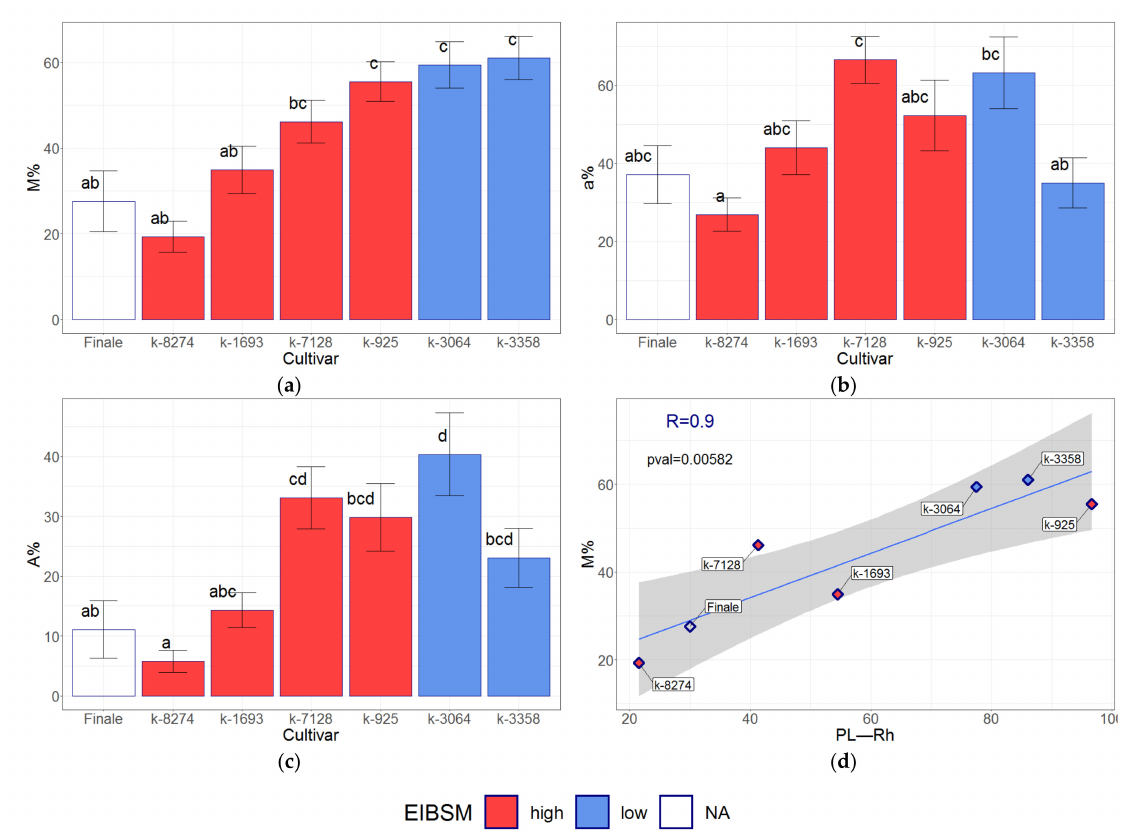
Figure 6. Characteristics of arbuscular mycorrhiza (AM) development by R. irregularis in the pea roots. ( a ) M % is the intensity of mycorrhizal colonization; ( b ) a % is the arbuscule abundance in mycorrhizal root fragments; ( c ) A % is the saturation of the root system with arbuscules; ( d ) relationship between the values of the pea stem length under conditions of monoinoculation with rhizobia (PL-Rh) and the values of intensity of mycorrhizal colonization ( M %). The values for each parameter, which are not significantly different from each other ( p ≤ 0.05), are marked with the same letter. Error bars represent standard errors. Markers of the rows of the diagram for high-EIBSM genotypes are highlighted in red, while those for low-EIBSM genotypes are highlighted in